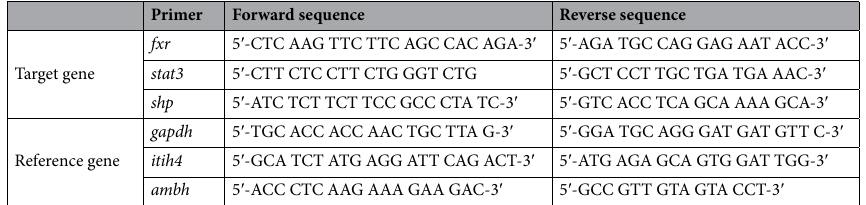
Table 8. List of primers sequences used for RT-qPCR.